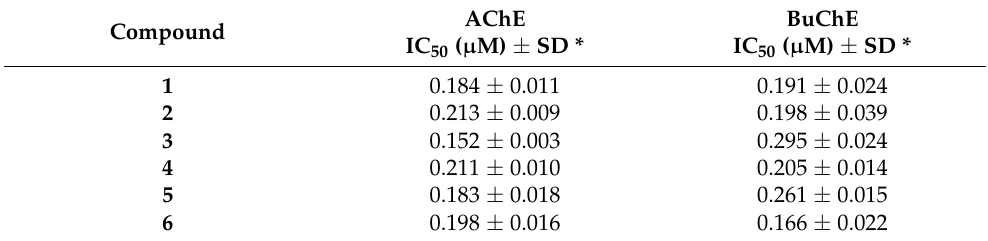
Table 2. AChE and BuChE inhibition activity of coumarin–thiadiazole hybrids 1-12 .